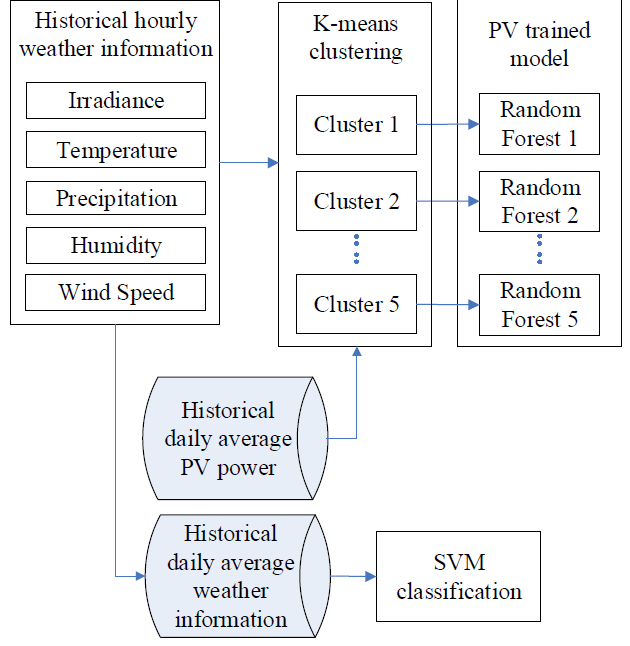
Figure 4. The detailed process of step 1.